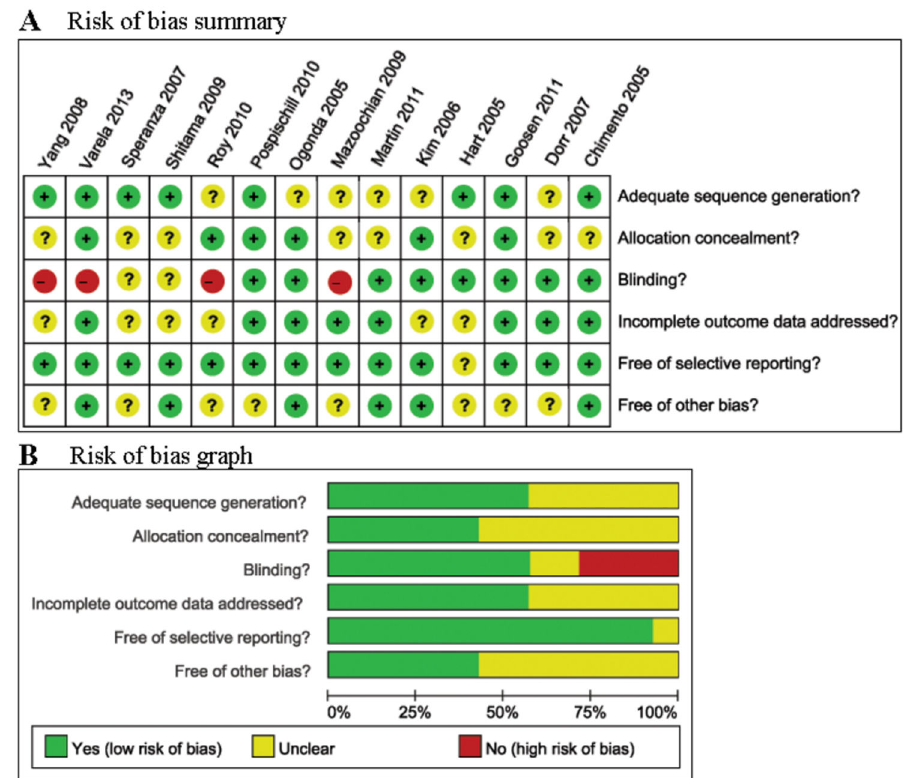
Figure 2. Risk of bias summary and